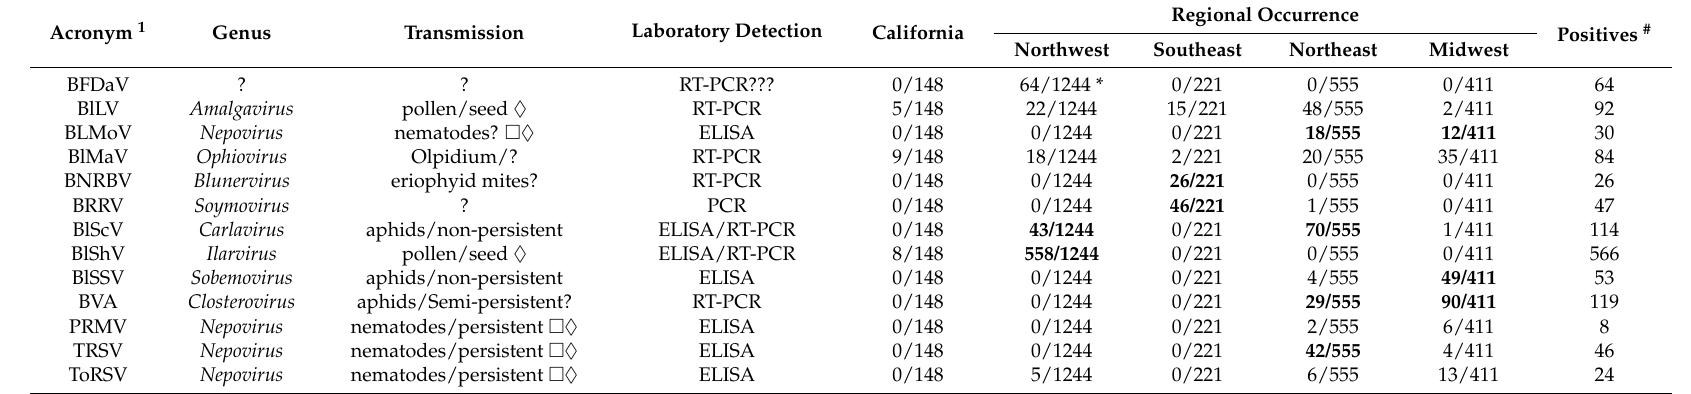
Table 2. Viruses detected in major highbush blueberry production areas in North